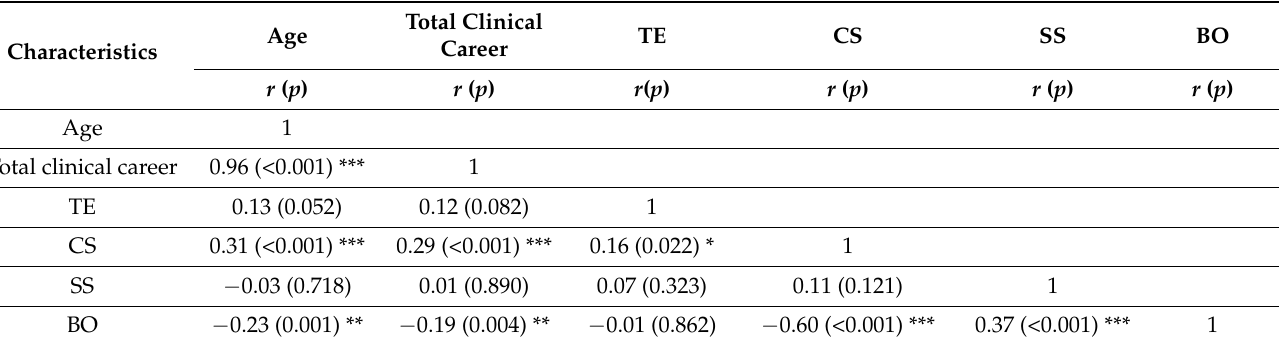
Table 5. Correlations between age, career length, traumatic event experience, compassion satisfaction, secondary traumatic stress, and burnout (N =